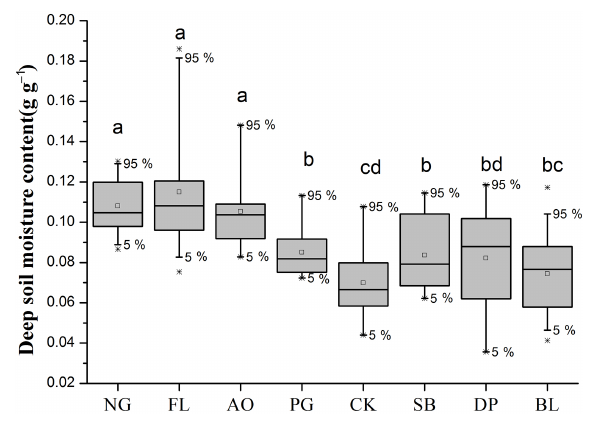
Figure 4. Deep soil moisture statistics for different vegetation types. Means with the same letter above the box are not significantly dif- ferent at the 0.05 significance level (LSD test); NG, FL, AO, PG, CK, SB, DP and BL refer to native grasses, farmland, apple orchard, pasture grasses, Caragana korshinskii , sea buckthorn, David peach and black locust,